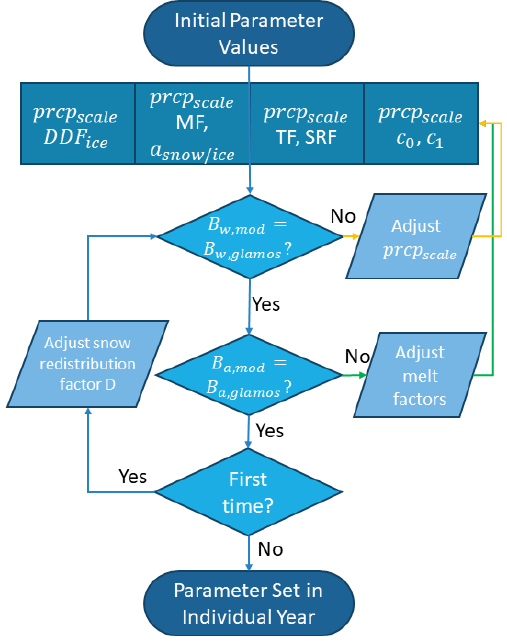
Figure 4. Calibration workflow used to obtain a prior estimate for the parameters of the model ensemble . B x , mod and B x , glamos are the modeled and GLAMOS glacier-wide mass balances, respec- tively, with x referring either to winter ( w ) or annual ( a ) values. The yellow arrows highlight the first iteration step, while the green arrows highlight the second iteration step. Figure altered from Huss et al.